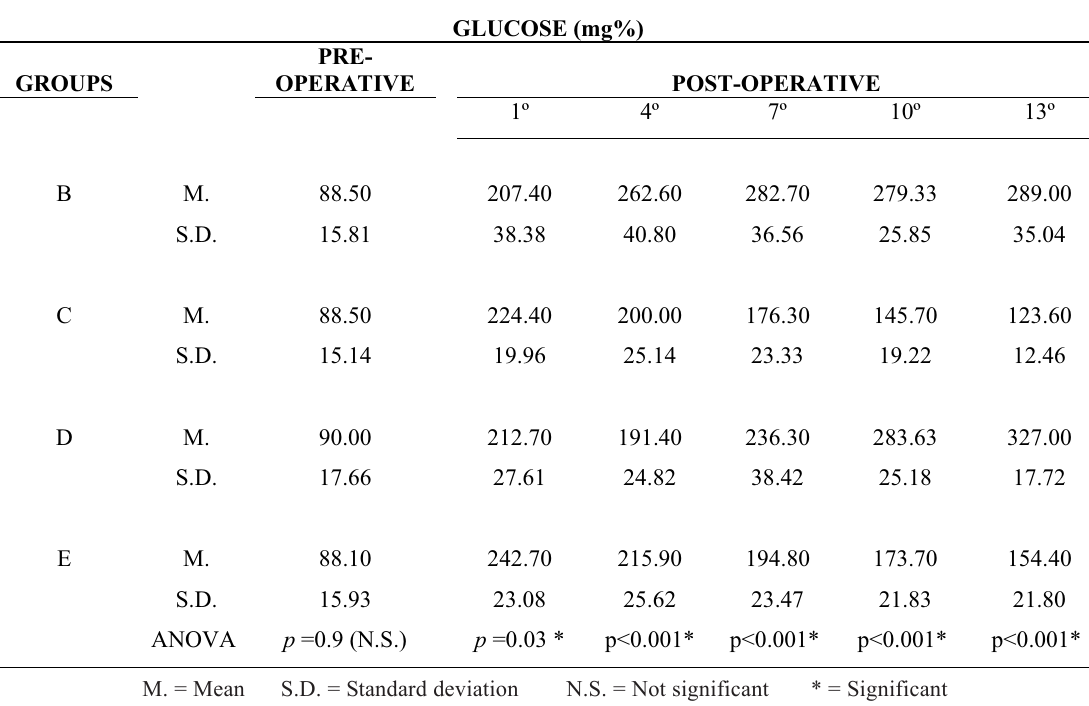
TABLE 1 - Values of the means and respective standard deviations of the fasting glucose levels (mg%) pre-operative and post-operative in the animals of groups B (apancreatic), C (autotransplant), D (allograft without immunosuppression) and E (allograft with immunosuppression).